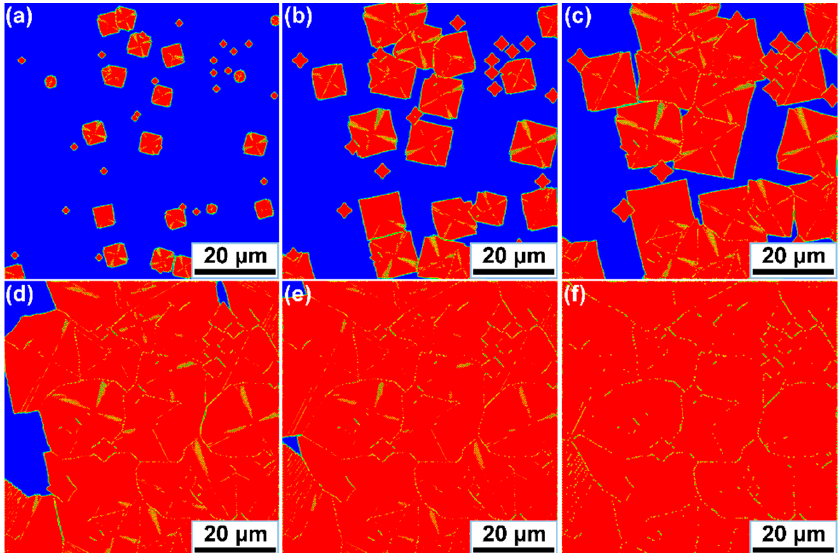
Figure 8. Simulation results of α -Mg/ β 1 -Mg 3 Nd eutectic growth for Mg-3Nd alloy at various times: ( a ) 0.27 s; ( b ) 0.53 s; ( c ) 0.82 s; ( d ) 1.15 s; ( e ) 1.53 s; ( f ) 2.21s.